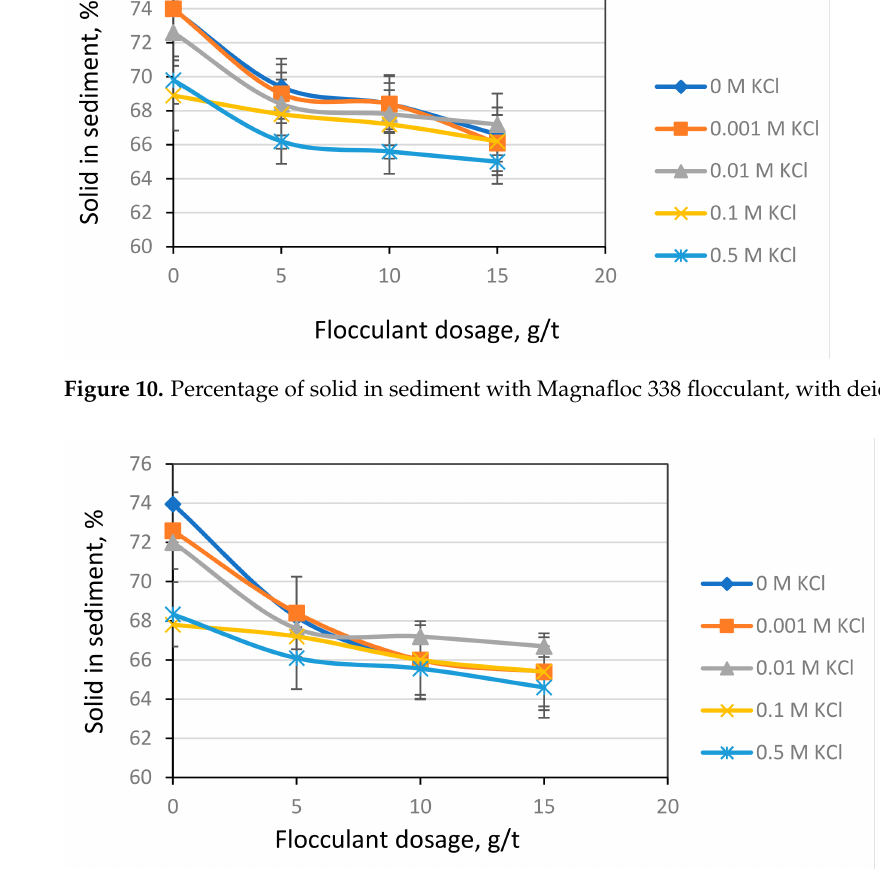
Figure 11. Percentage of solid in the sediment with Magnafloc-1011 flocculant, with industrial water.